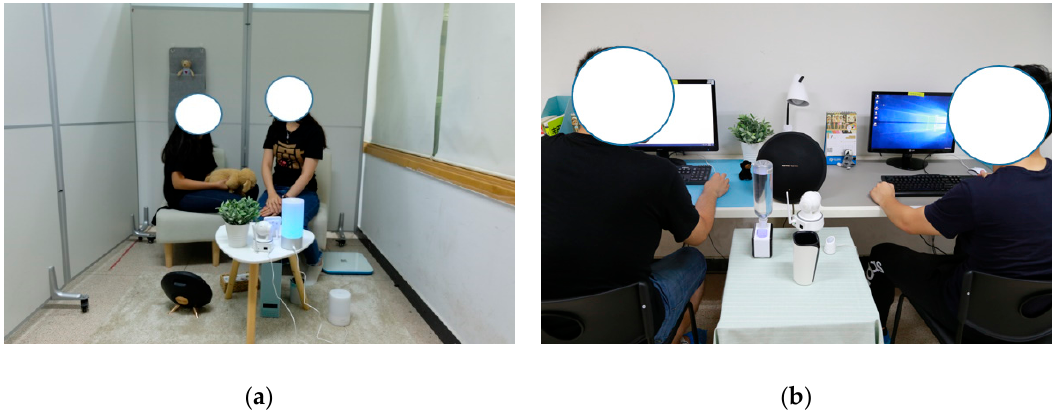
Figure 3. Example of scenes in Experiment 2: ( a ) a roommate dyad in the living space and ( b ) a colleague dyad in the workspace.